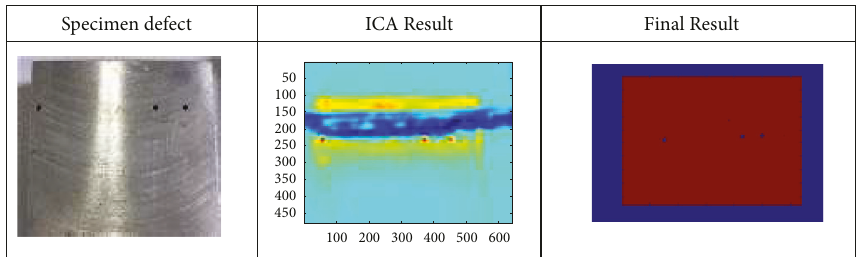
Figure 22: The specimen defect, the ICA result, and the final result.